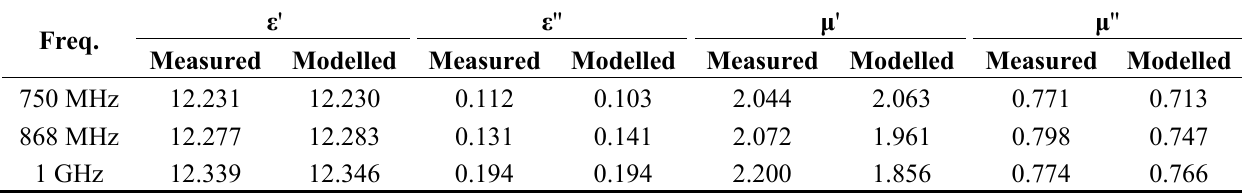
Table 1. Measured and modelled values of the complex permittivity and permeability of the hexaferrite sample in the frequency band of interest. ε Freq.